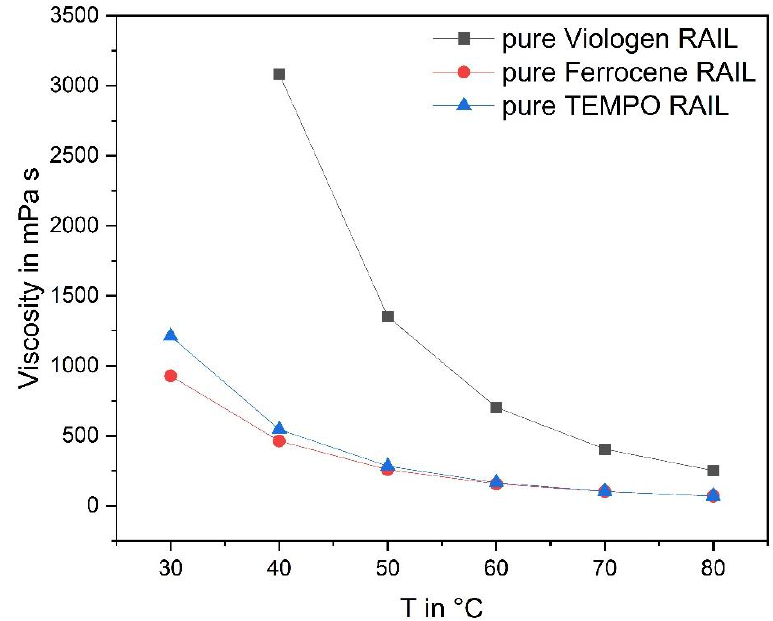
Figure 2. Viscosity of pure RAILs 3 , 6 , 9 from 30 to 80 °C .